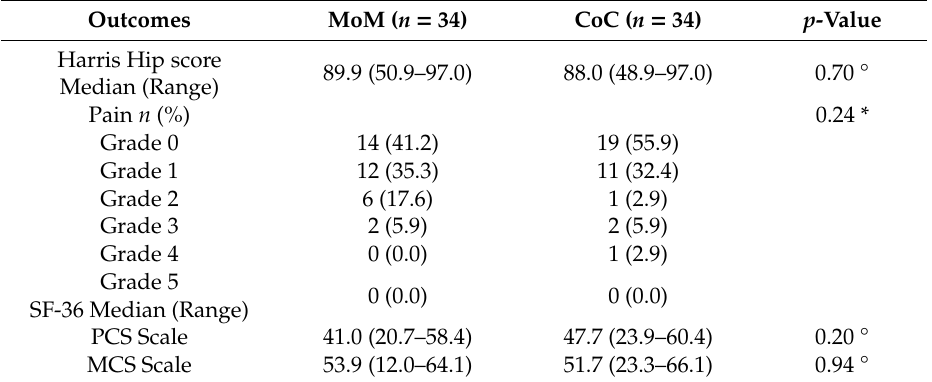
Table 2. Patient clinical